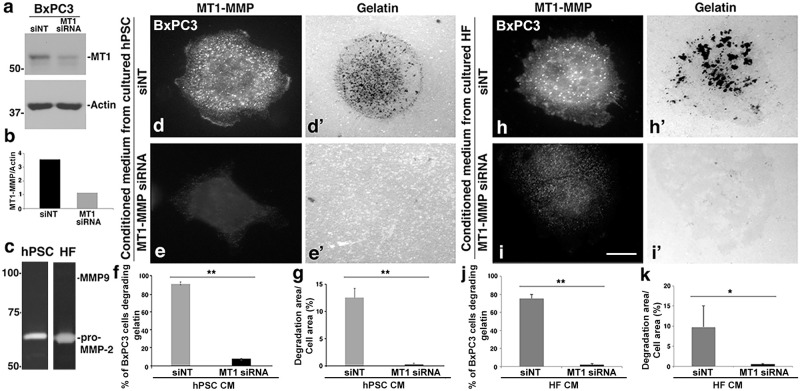
PDAC cell MT1-MMP is essential for PDAC cell ECM remodeling.MT1-MMP depletion in BxPC3 cells inhibits matrix degradation in the presence of fibroblast CM. (a) Western blot of BxPC3 cells treated for 72 h with control or siRNA to MT1-MMP. The relative levels of MT1-MMP normalized to actin are depicted in the bar graph (b). (c) Zymogram of CM collected from hPSCs or HFs confirming the presence of pro-MMP2 in these cells. (d-e, h-i) Fluorescence micrographs of BxPC3 cells treated with control siRNAs or MT1-MMP-targeted siRNAs for 3 days. The cells were then seeded onto green fluorescent gelatin-coated coverslips and cultured in CM from hPSCs (d-e) or HFs (h-i) for 8 h prior to fixation and staining with antibodies to MT1-MMP. The knockdown of MT1-MMP in the BxPC3 cells significantly reduced ECM degradation by these cells in the presence of CM from both hPSCs and HFs. Scale bar = 10μm. (f-g, j-k) Bar graphs quantifying matrix degradation by BxPC3 cells as described above. Both the percentage of BxPC3 cells degrading matrix (f, j) and the total area of matrix degraded per cell (g, k) in BxPC3 cells decreased dramatically following MT1-MMP depletion in PDAC cells incubated with CM from hPSCs (f, g) or HFs (j, k). Graphs represent averages ± SEM from at least 3 independent experiments. *p <0.05. **p <0.01.